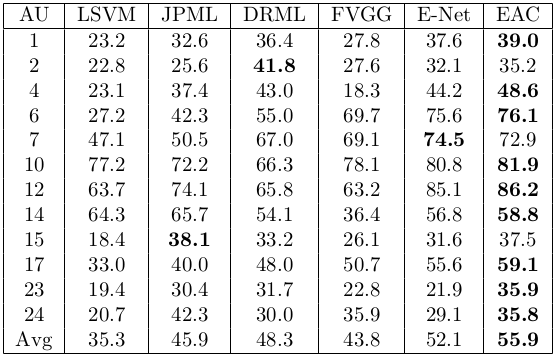
Table from the paper: EAC-Net: A Region-based Deep Enhancing and Cropping Approach for Facial Action Unit Detection
Table text:
AU
LSVM
JPML
DRML
FVGG
E-Net
EAC
1
23.2
32.6
36.4
27.8
37.6
39.0
2
22.8
25.6
41.8
27.6
32.1
35.2
4
23.1
37.4
43.0
18.3
44.2
48.6
6
27.2
42.3
55.0
69.7
75.6
76.1
7
47.1
50.5
67.0
69.1
74.5
72.9
10
77.2
72.2
66.3
78.1
80.8
81.9
12
63.7
74.1
65.8
63.2
85.1
86.2
14
64.3
65.7
54.1
36.4
56.8
58.8
15
18.4
38.1
33.2
26.1
31.6
37.5
17
33.0
40.0
48.0
50.7
55.6
59.1
23
19.4
30.4
31.7
22.8
21.9
35.9
24
20.7
42.3
30.0
35.9
29.1
35.8
Avg
35.3
45.9
48.3
43.8
52.1
55.9